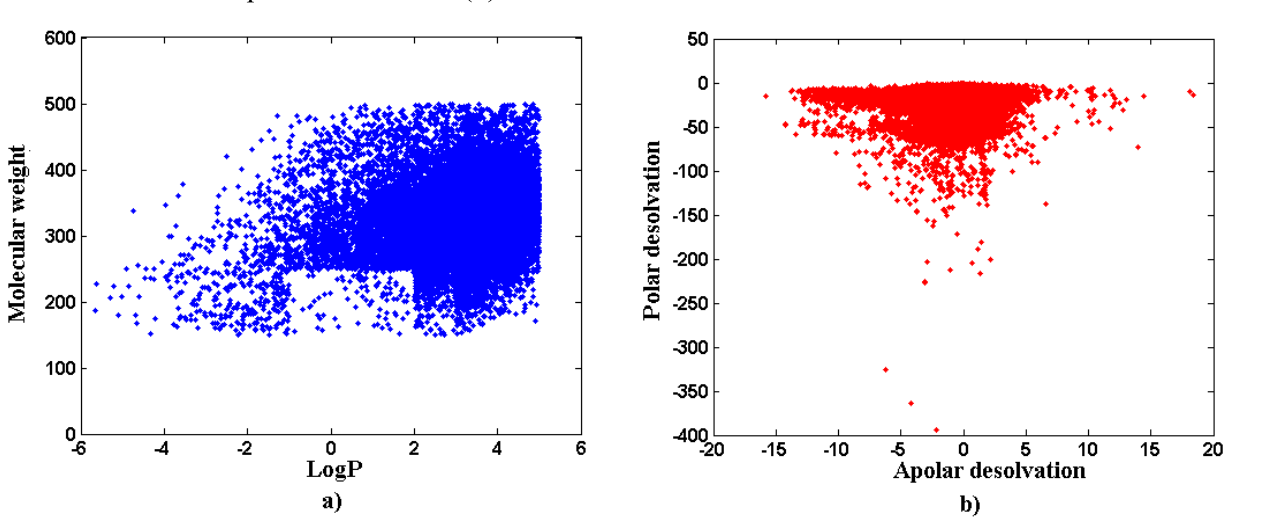
Figure 4. The distribution of the calculated logP vs. molecular weight (a) and apolar desolvation vs. polar desolvation